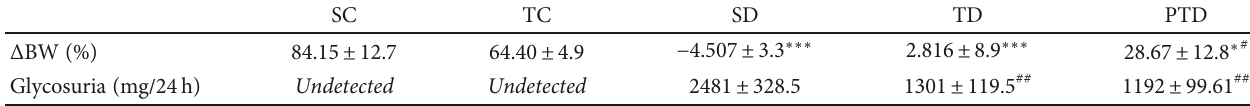
Table 1: Body weight gain and glycosuria of SC, TC, SD, TD, and PTD rats. SC